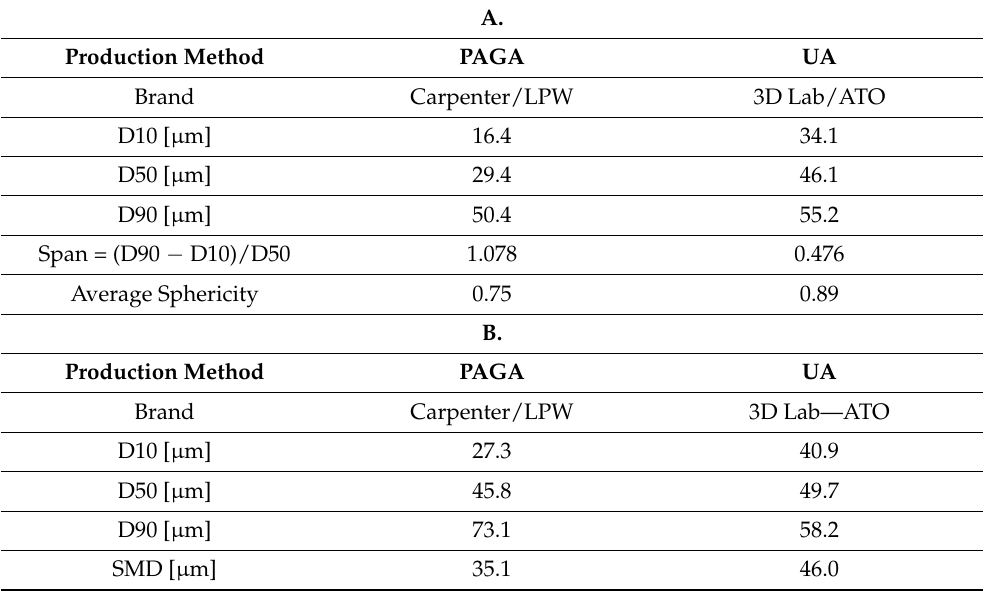
Table 2. A. PSD of the powder batches as in the binary image processing (particle counts). B. PSD of the powder batches based on the weight fractions.